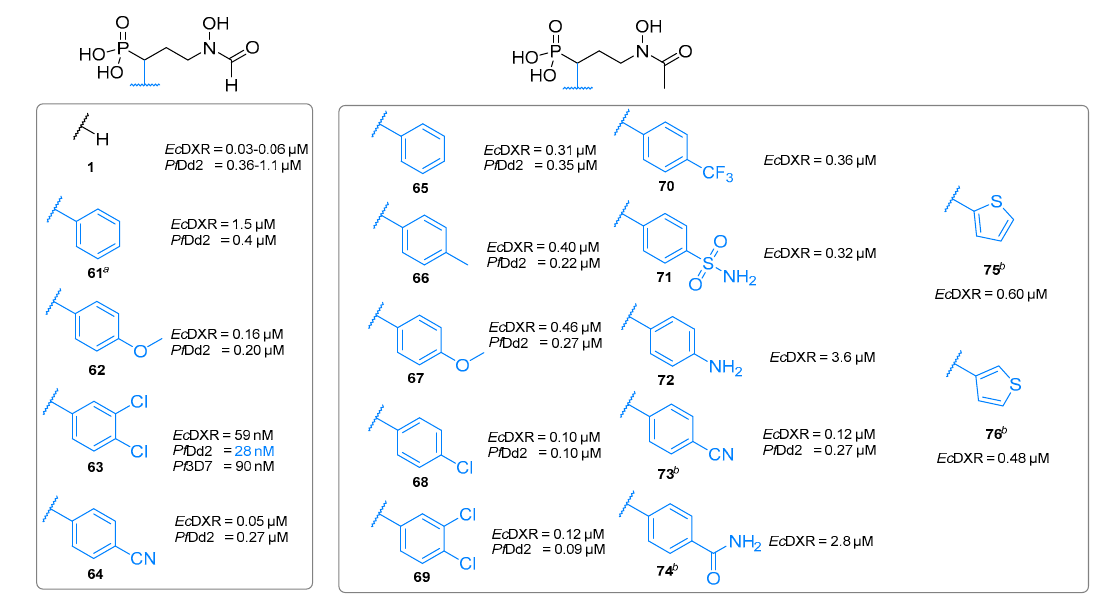
Figure 17. Antibacterial and antiplasmodial activities of α -phenyl derivatives ( 61 – 76 ). a